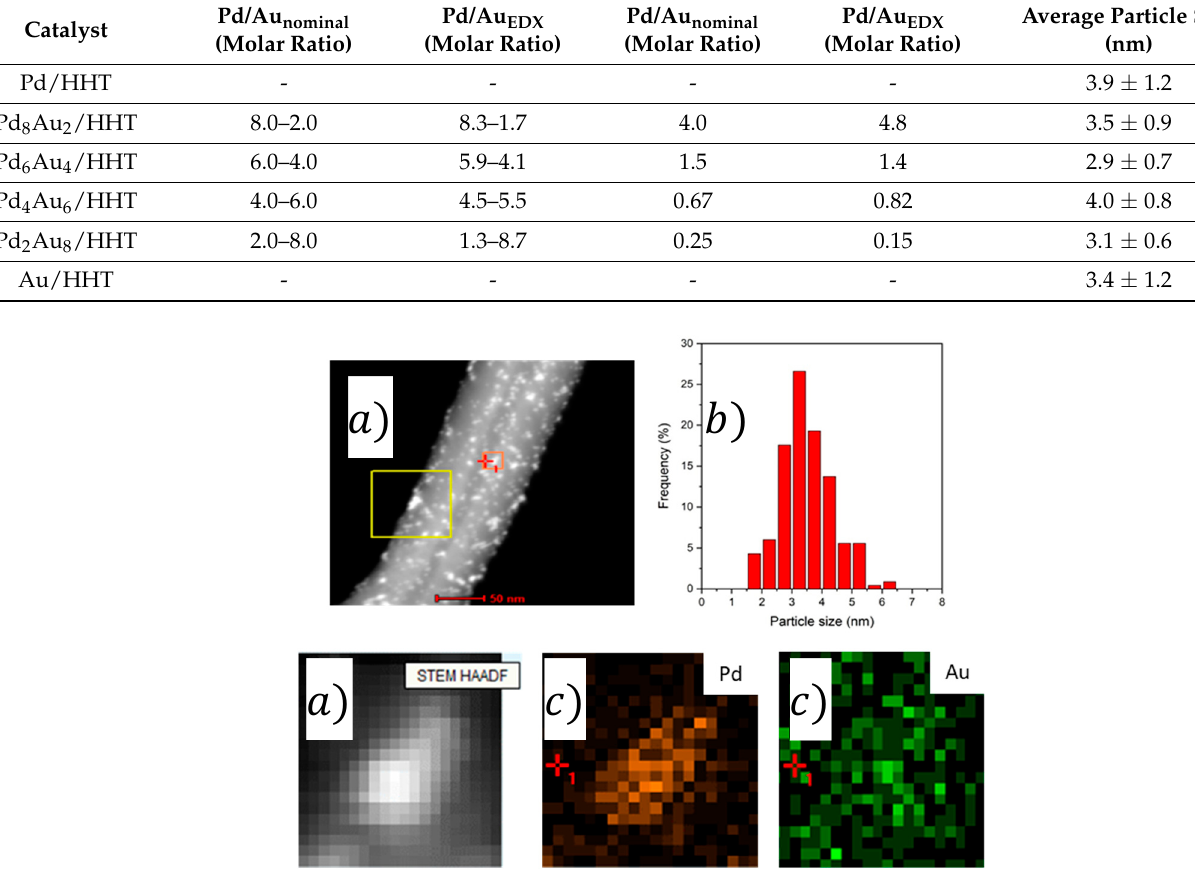
Figure 1. ( a ) TEM, ( b ) NP size distribution, and ( c ) EDX analysis of Pd 8 Au 2 catalyst.